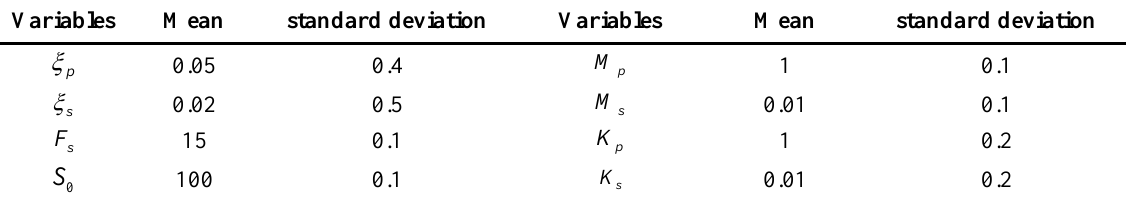
standard deviation Mean Variables